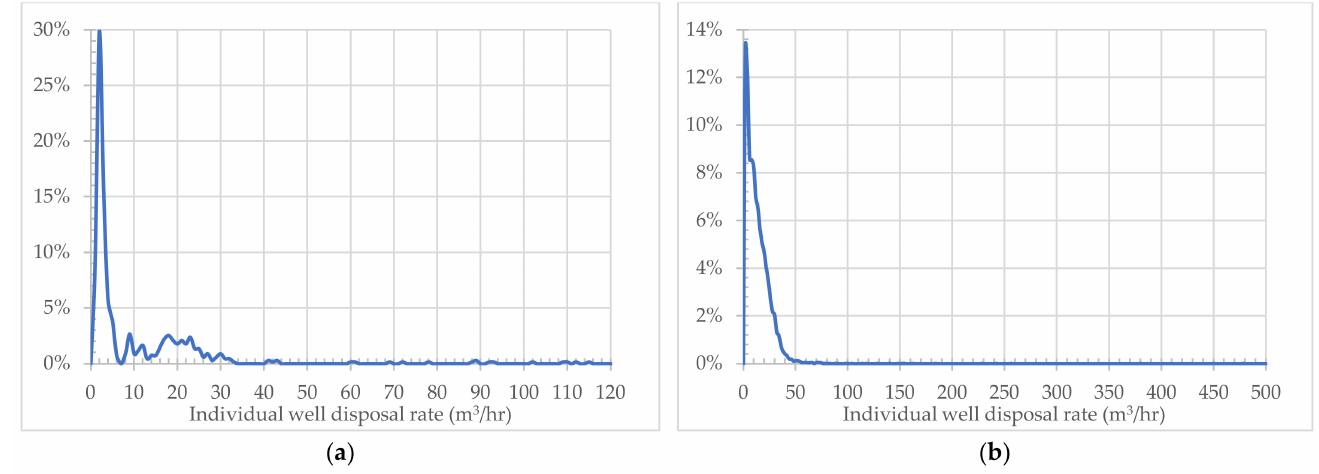
Figure A8. Historical per-well water injection rate ( X -axis) frequency ( Y -axis) distributions (January 1962–December 2022) in ( a ) the Rex Formation; ( b ) the Lloydminster Sandstone Formation.